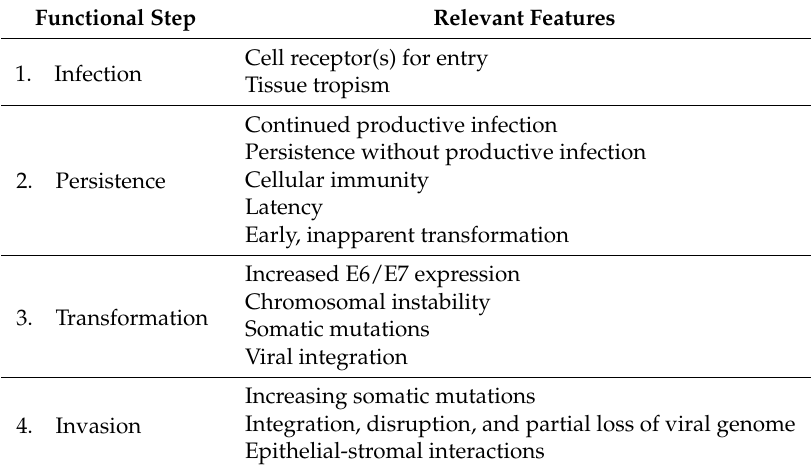
Table 2. Distinct steps in the pathway from HPV infection to